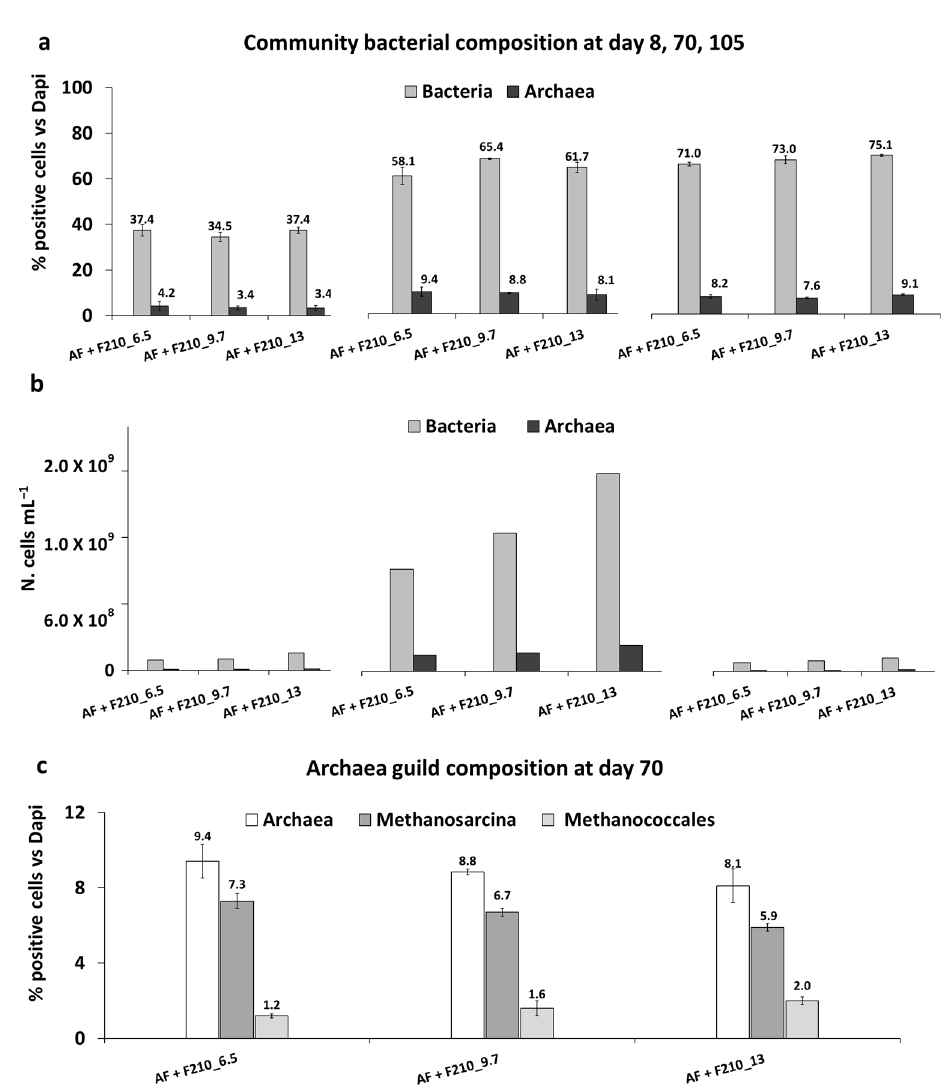
Figure 4. ( a ) Relative microbial community composition at day 8 (left), 70 (center), and 105 (right); ( b ) community composition in terms of Bacteria and Archaea abundance in the combined bioaug- mented tests at day 8 (left), 70 (center), and 105 (right); values were calculated using the microbial relative abundance and the total microbial abundance; ( c ) relative guild composition of methanogens at day 70; only Methanosarcina (grey bars) and Methanococcales (light grey bars) were detected and are reported. Relative abundance of Archaea in the microbial community is also reported (white bars). The standard deviations of the mean percentage values calculated for each sample over three replicates are shown.